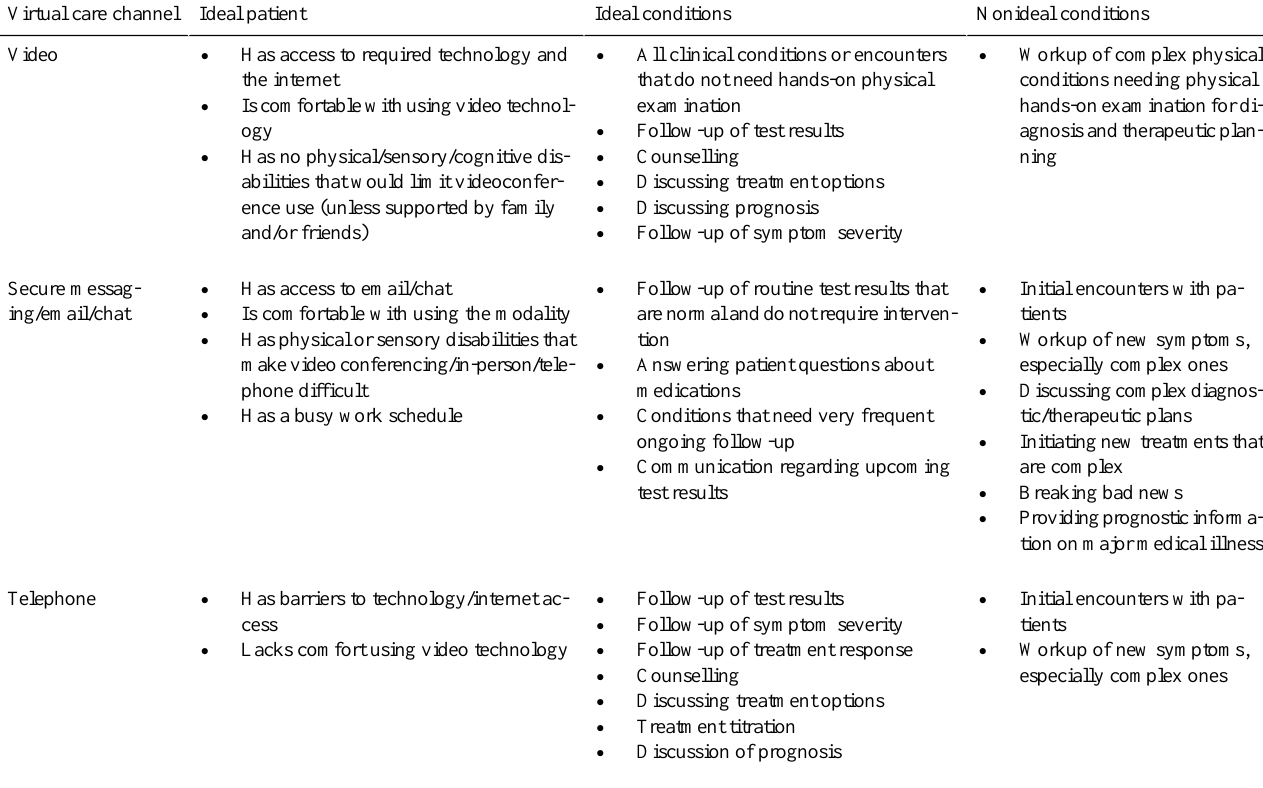
Table 1. Guide to virtual care channel